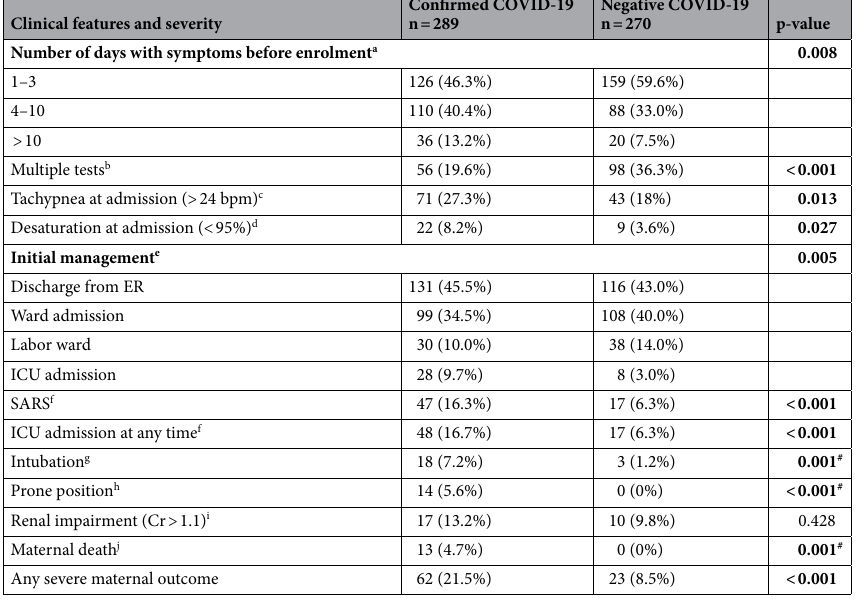
Table 2. Clinical features and severity of SARS-CoV-2 infection of women according to the COVID-19 status during pregnancy or postpartum. Chi-squared tests were applied for all comparisons, except those indicated with # (Fisher’s Exact test). Missing information for a 20, b 3, c 60, d 39, e 1, f 2, g 57, h 59, i 328, j 48. Significant values are in bold.